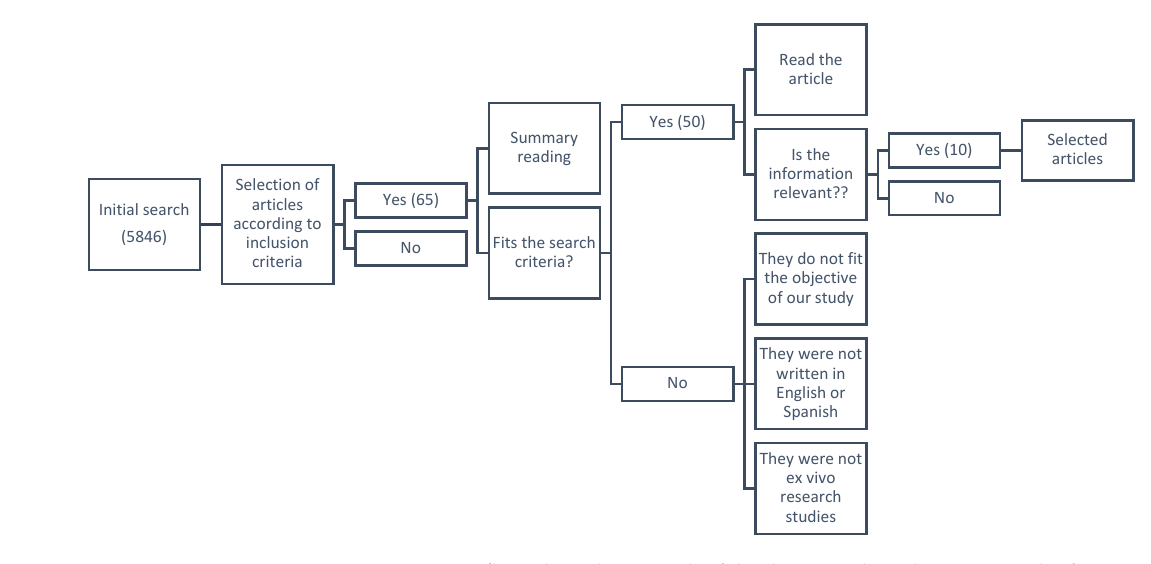
Figure A2. PRISMA flow algorithm; search of databases: PubMed, Scopus, Web of Science. Keywords: stent, design, material, encrustation, biodegradable, ex vivo, ureter, urinary tract models; time period